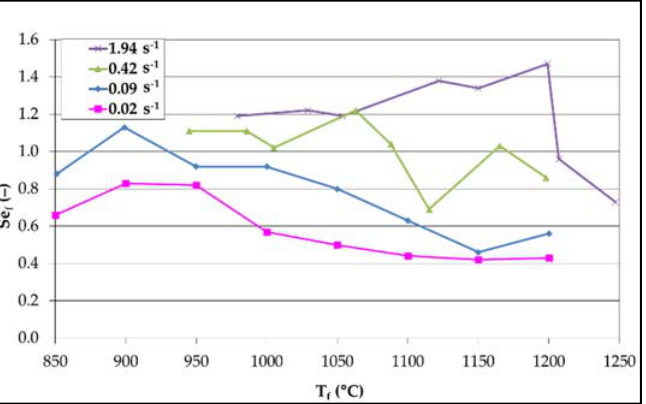
Figure 1. Dependence of the fracture strain intensity ( Se f ) on the test temperature ( T f ), and strain rate, Bi-free steel.